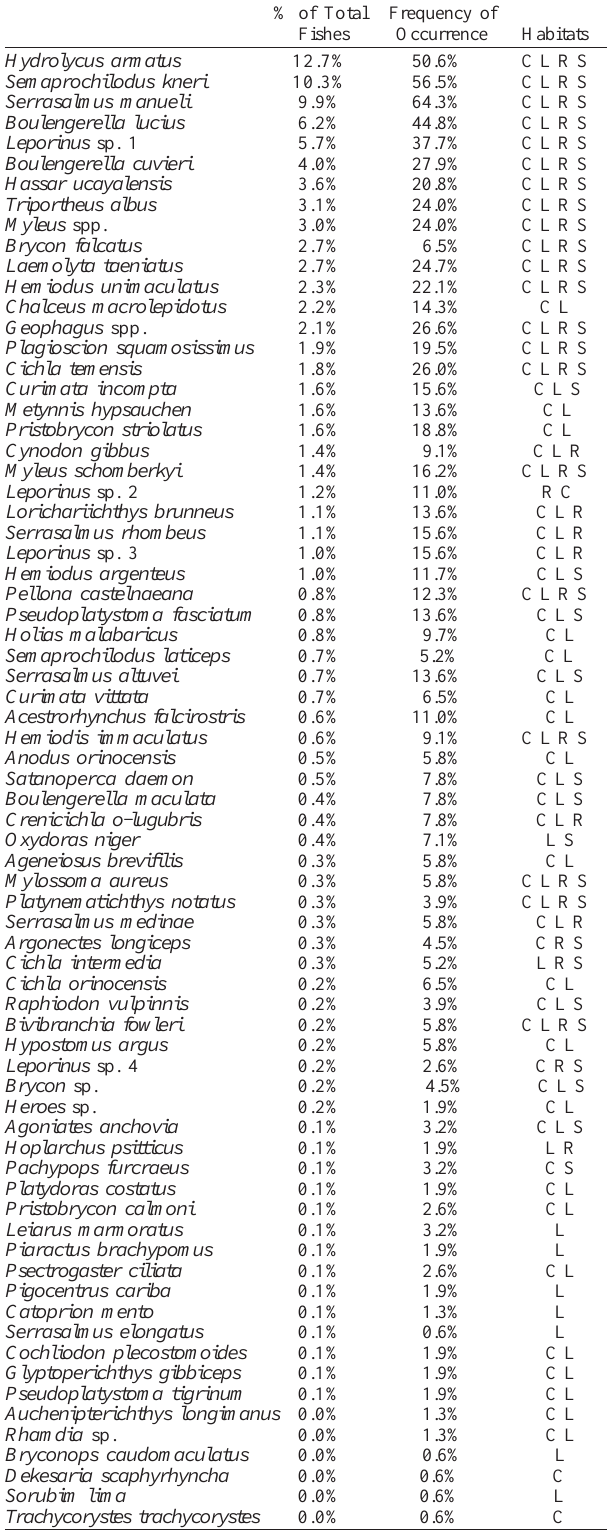
Table 1 . Percentage of the total number individuals repre- sented by each species and the frequency which each was collected in the 150 samples. Habitat abbreviations are: C – Creek; L – Lagoon; R – River Channel; S – Sand